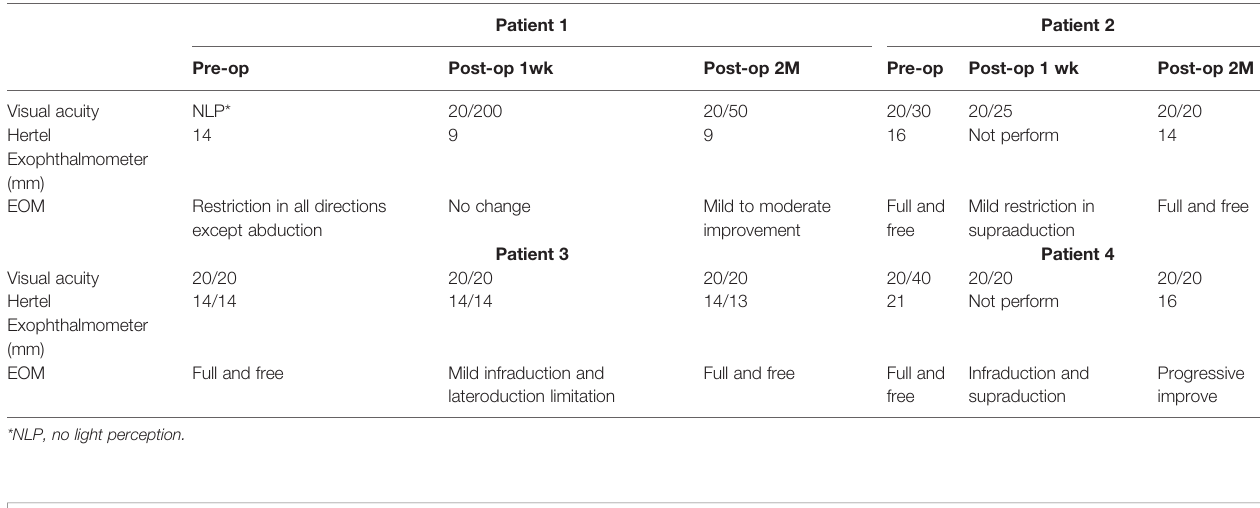
TABLE 2 | Preoperative and postoperative ophthalmic